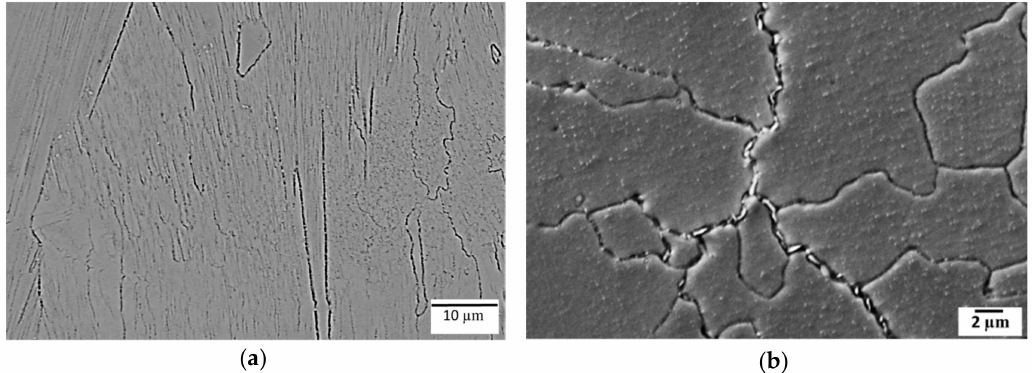
Figure 3. ( a ) Microstructure of solution heat-treated (SHT) condition (electrolytically etched with oxalic acid), showing ( b ) precipitates residing in the grain boundaries and